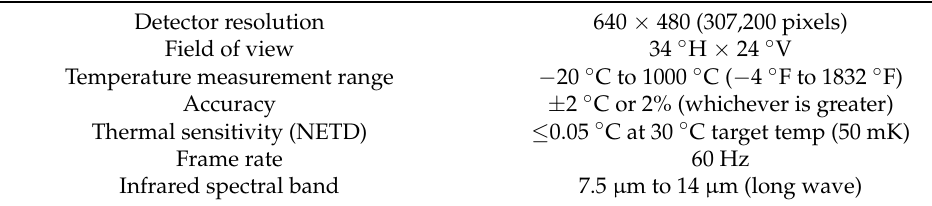
Table 2. IR camera properties reported by the manufacturer.